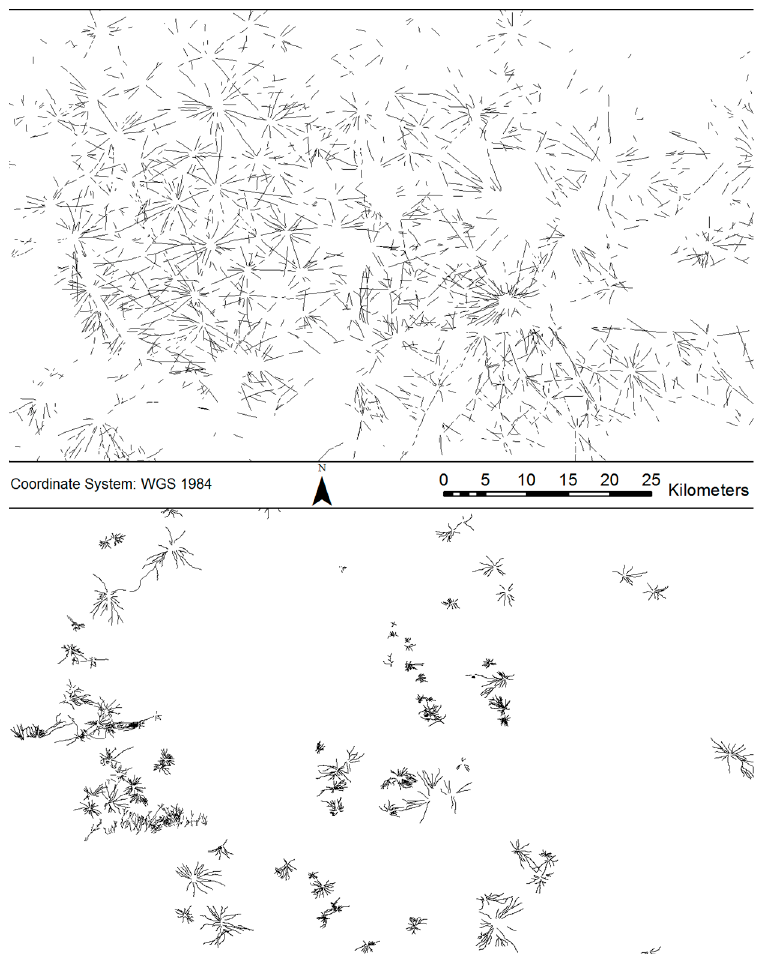
Figure 10. Morphologically, the hollow ways of Southern Mesopotamia (below) are similar to previously documented hollow ways in the North Jazira (above [7]), although they are smaller. Both of these images are at the same scale, indicated by the scale bar in the middle. In the lower image, some hollow ways connect sites, such as the pair of sites visible in the top left of the image.